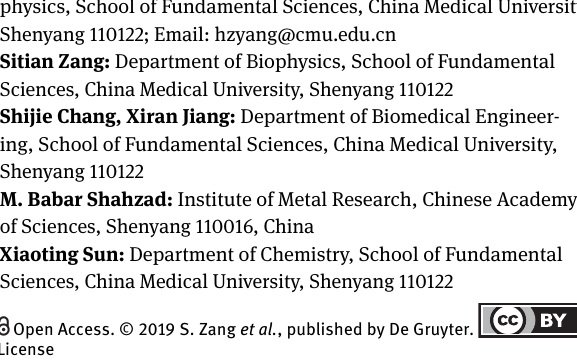
The ceramic-based drug carriers have attracted in- creasing attention with the developments in medicine, pharmaceutics, and material science. Popular bioceram- ics include: beta tricalcium phosphate ( β -TCP), hydrox- yapatite, mesoporous silica, zirconia hydroxyapatite